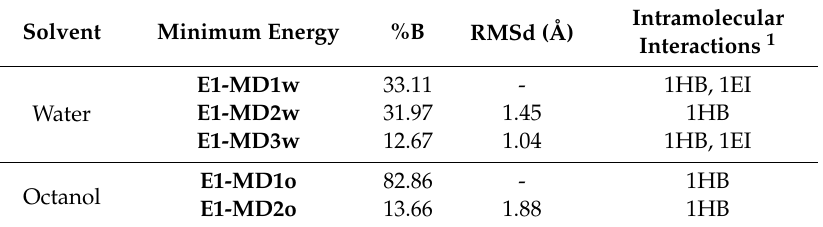
Table 6. % B, RMSd values and intramolecular interactions of the most probable energy minima for E1, obtained after the minimization of all MD frames in both solvents. RMSd values are reported in Å, and they are calculated on the heavy atoms of E1 compared to the global energy minima ( E1-MD1w and E1-MD1o ). Solvent Minimum Energy %B RMSd